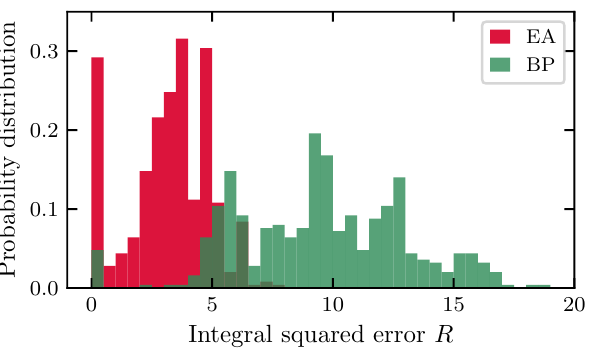
Figure 4. Error probability distribution comparison between EA and BP algorithms for constant estimation based on 100 data